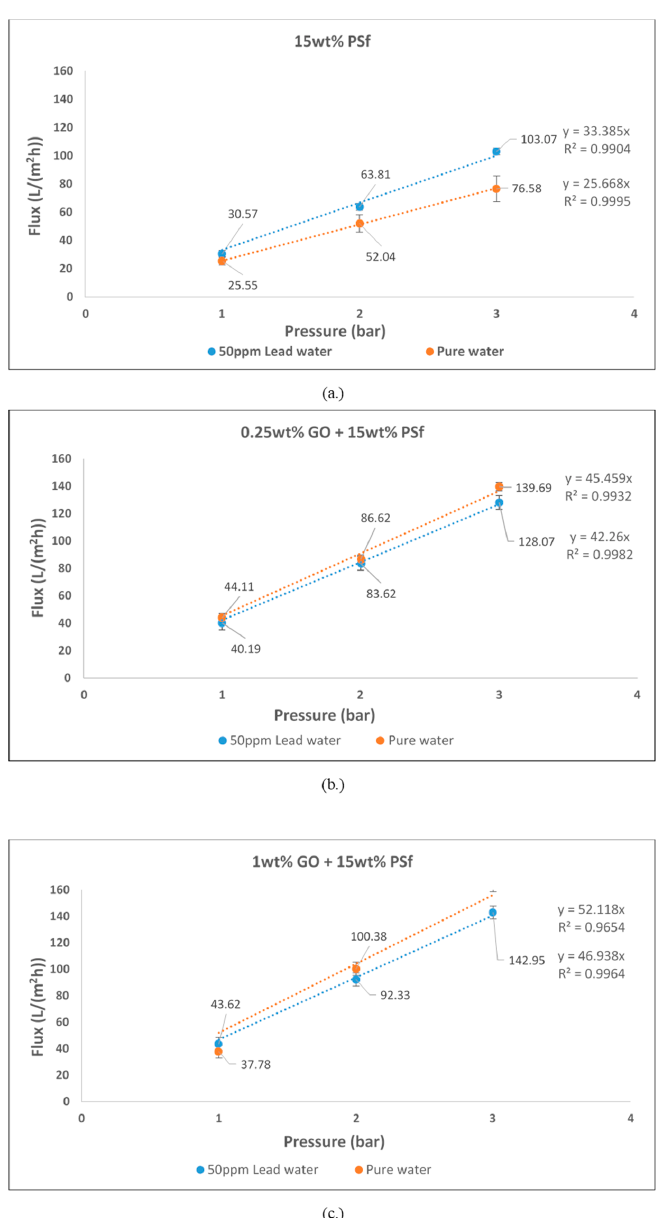
Figure 5. Pure water flux and 50 mg/L lead flux of ( a ) 15 wt % polysulfone (PSf), ( b ) 0.25 wt % graphene oxide (GO) and 15 wt % PSf, and ( c ) 1 wt % GO and 15 wt % PSf.